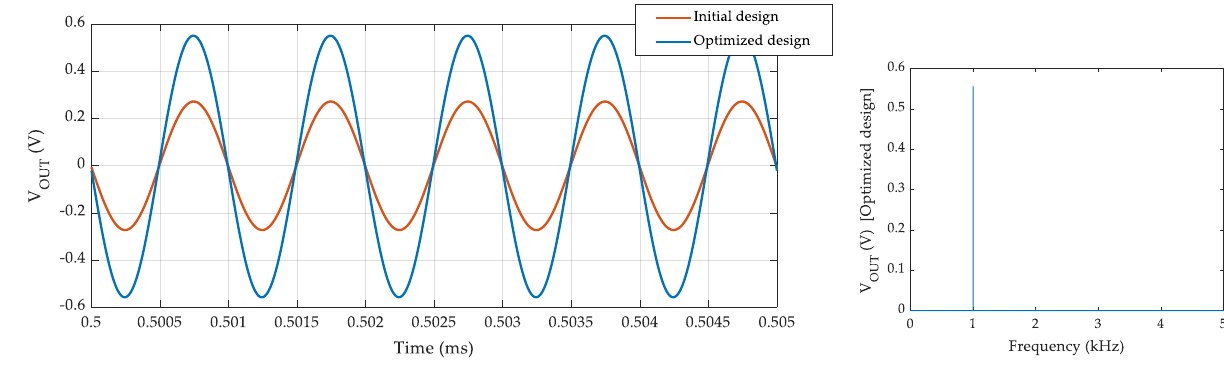
Figure 22. Comparison between the initial design and the optimized design with the second iteration.